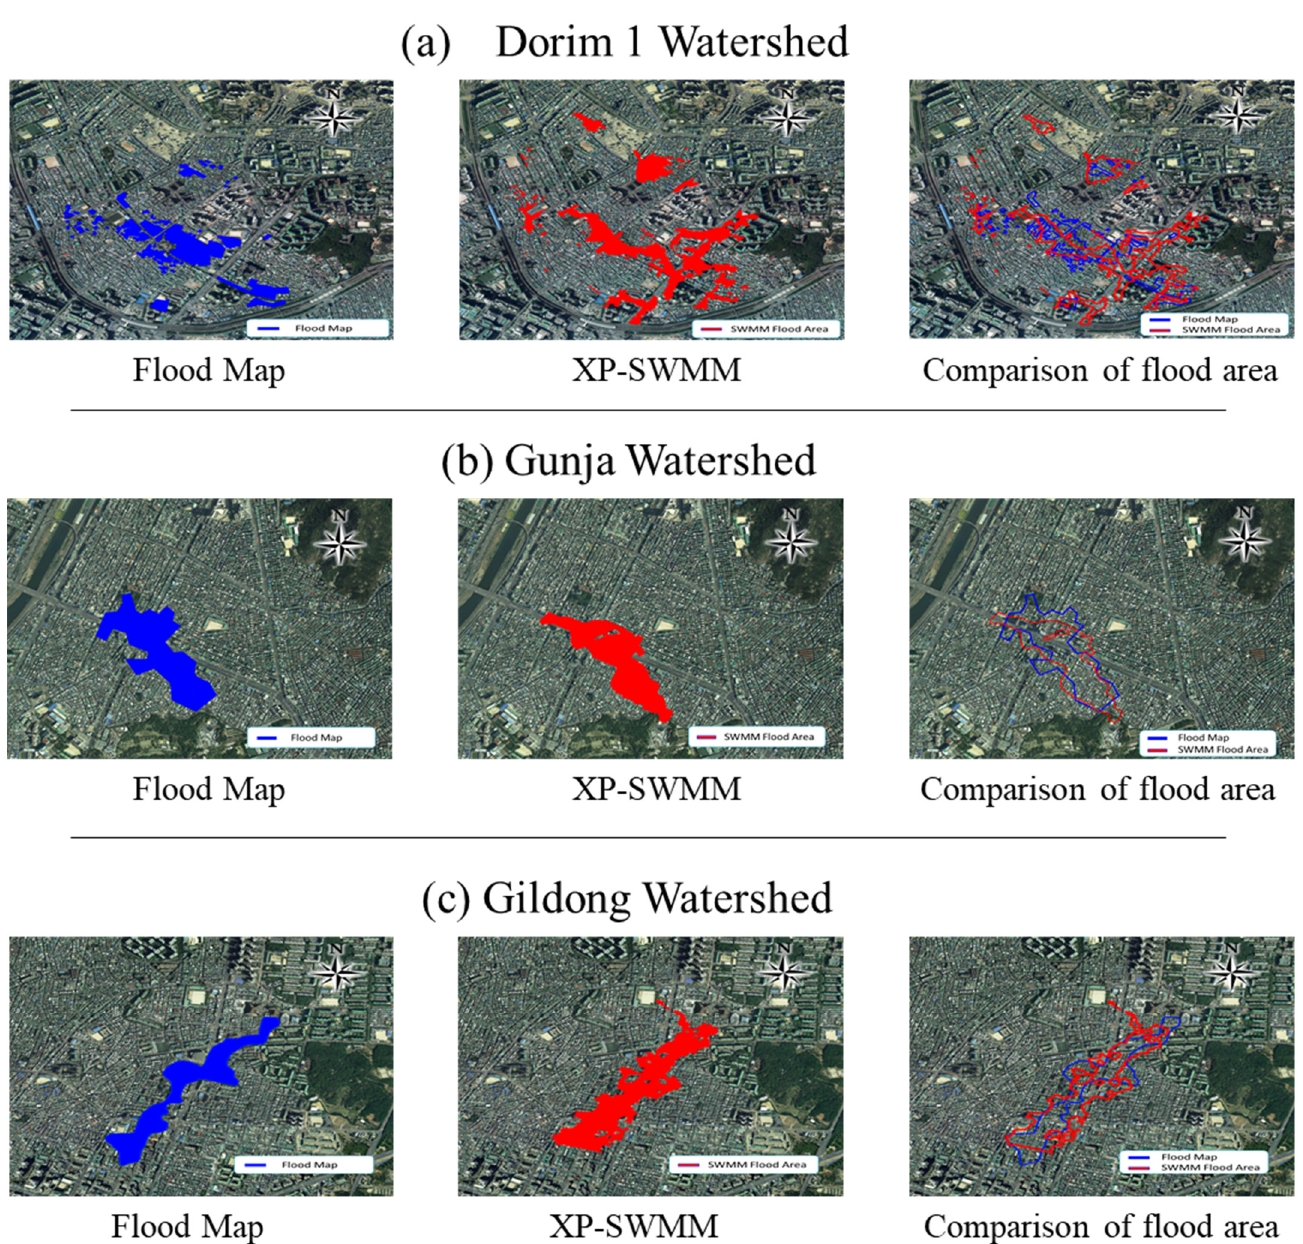
Figure 17. Comparison of inundation area.